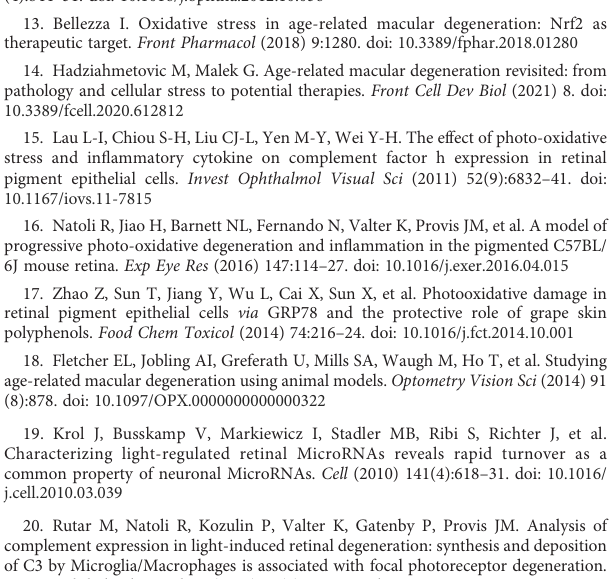
SUPPLEMENTARY FIGURE 2 Distinct gene pro fi les within dual in fl ammatory pathways in response to early photo-oxidative damage. (A, B) Heat maps show the expression pro fi le of differentially expressed genes within cluster 1 and 2, with unique genes within each cluster. Signi fi cance P<0.05,